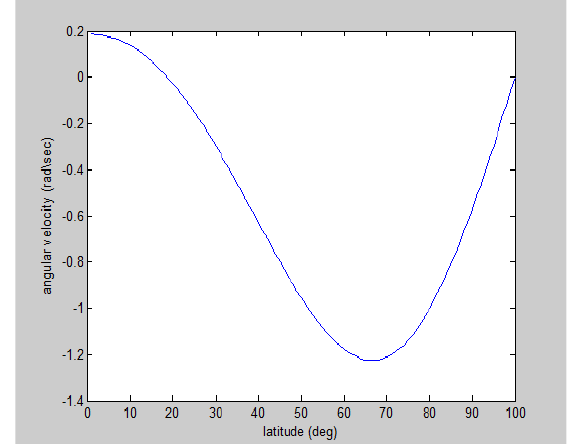
Fig. 3: Differential rotation distribution on sun